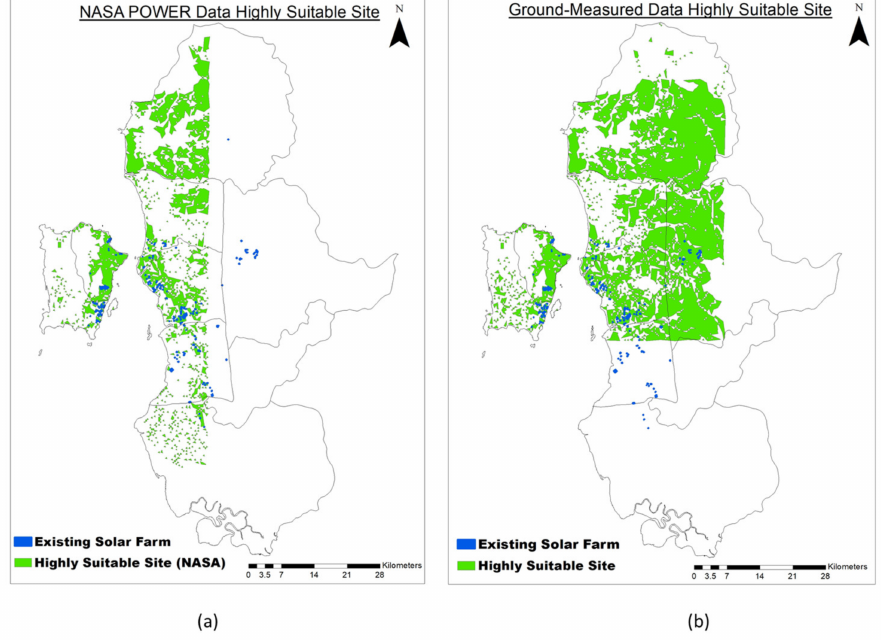
Figure 7. Model validation ( a ) NASA POWER data map validation, ( b ) ground-measured data map validation.